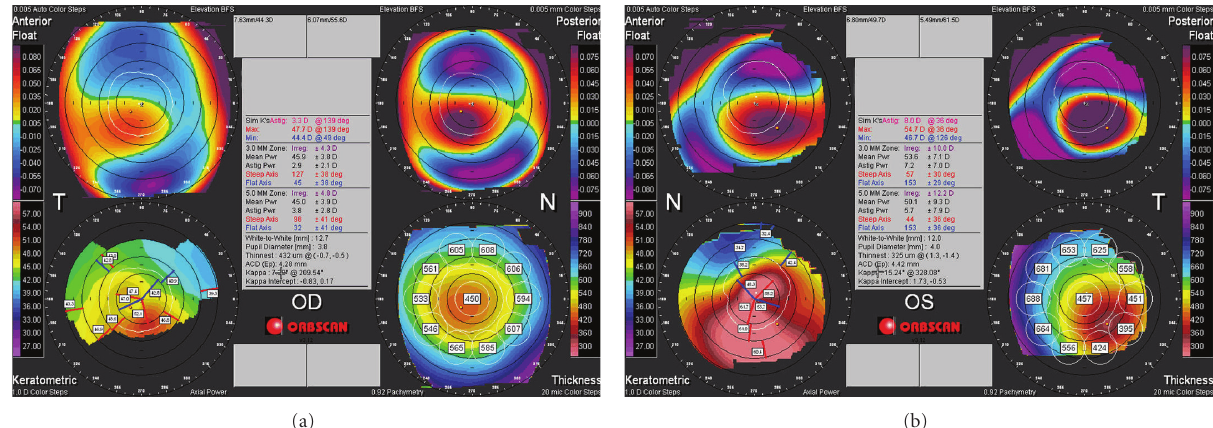
Figure 1: Corneal topography of the right and left eyes showing advanced posterior surface elevation and steepening.